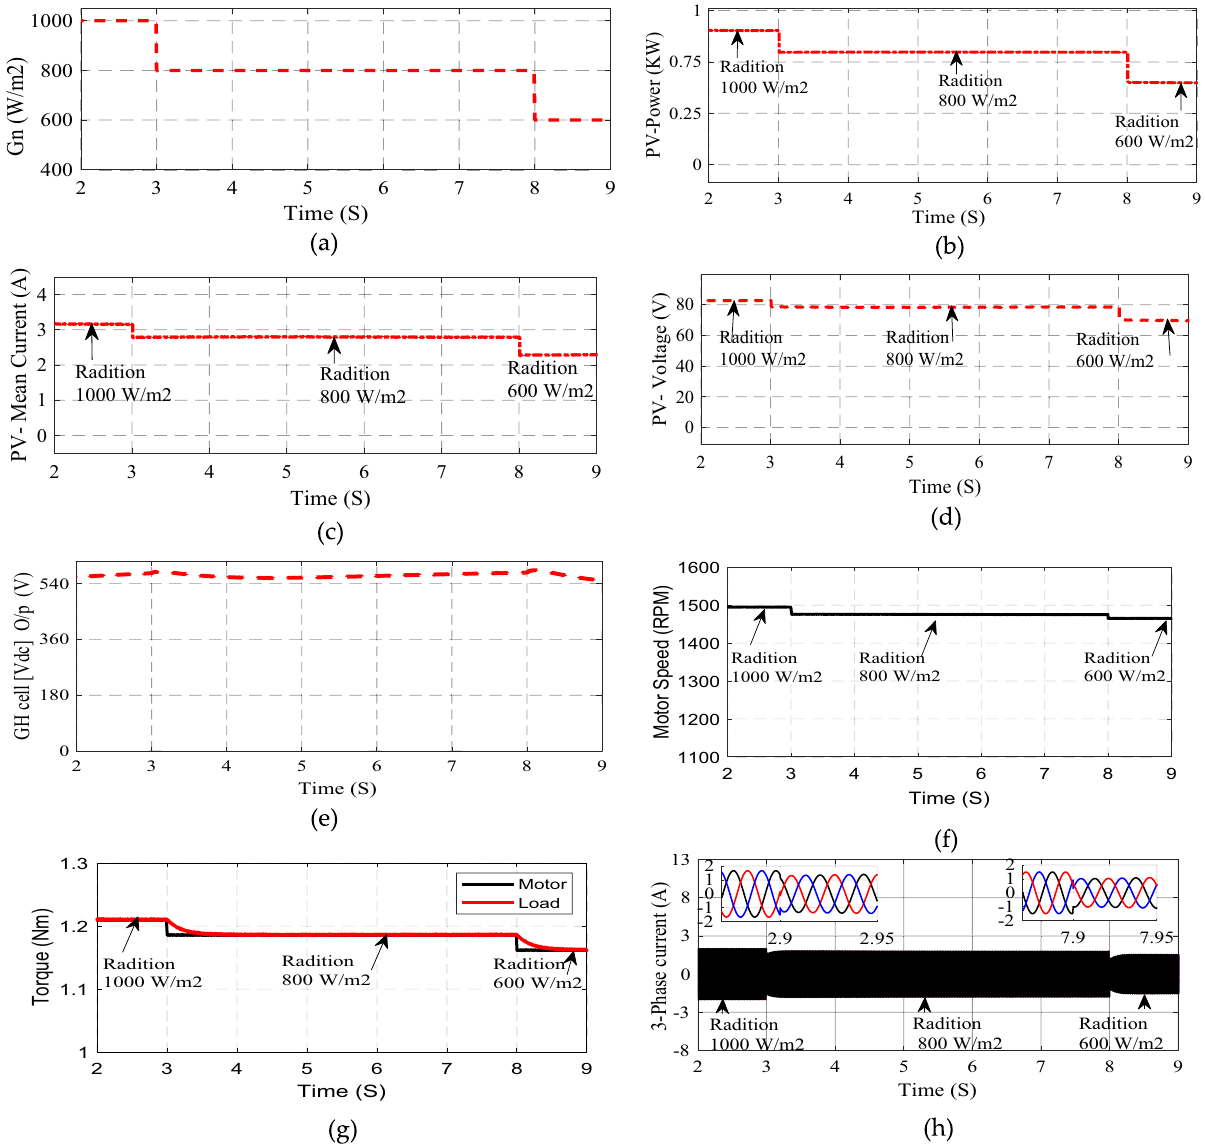
Figure 10. System response at varied Irradiation levels ( a ) Irradiation ( b ) PV-power (V) PV current ( d ) PV-voltage ( e ) Voltage after high gain cell ( f ) Motor speed ( g ) motor and load torque ( h ) Motor phase